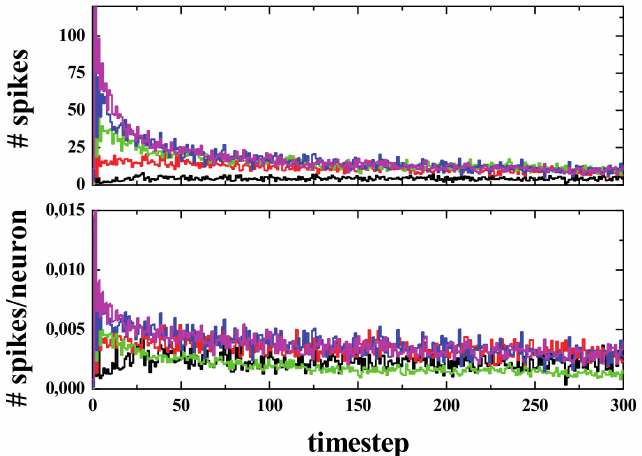
Figure 11. (Color online) Total number of spikes (Top panel) and averaged number of spikes per neuron (i.e., total number of spikes divided by total population, Bottom panel) vs. time for five different initial densities as labelled: 10 (black), 15 (red), 20 (green), 25 (dark blue), and 30%